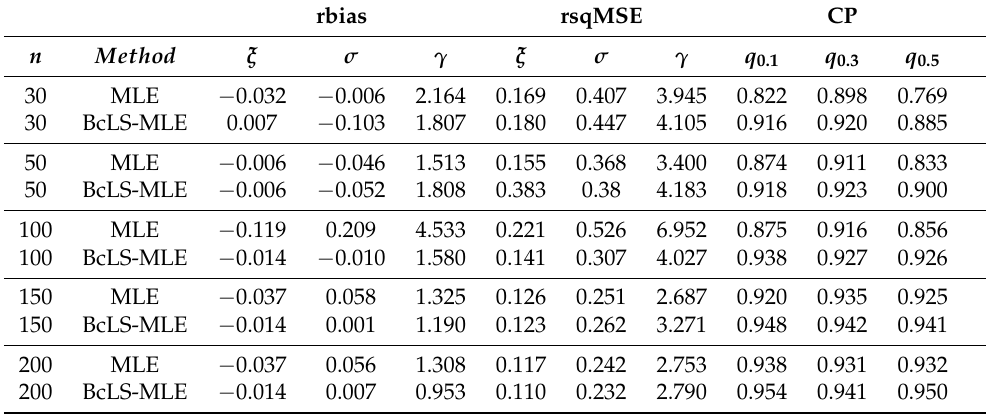
Table 4. The rbias and rsqMSEs of the BcLS-MLE and MLE, and the CP of S ( y 0 | Θ ) for LPN ( Θ ) with ξ = 5, σ = 0.6, γ = 5, and 1 − α =